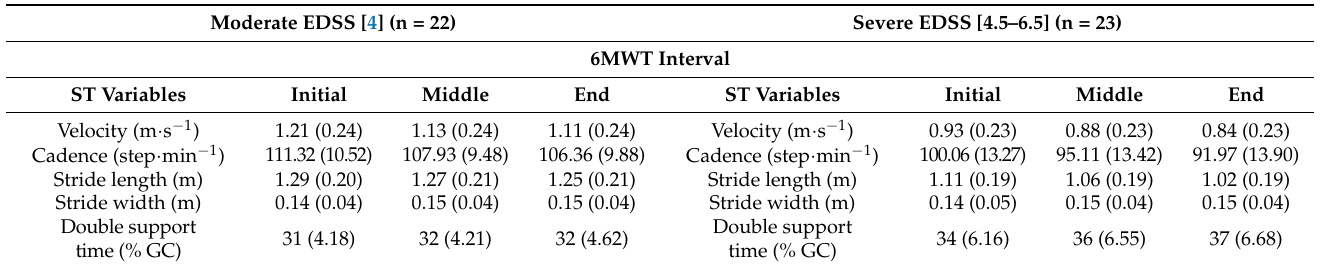
Table 4. Spatio-temporal variables during each interval of the 6MWT for PwMS with moderate and severe EDSS.